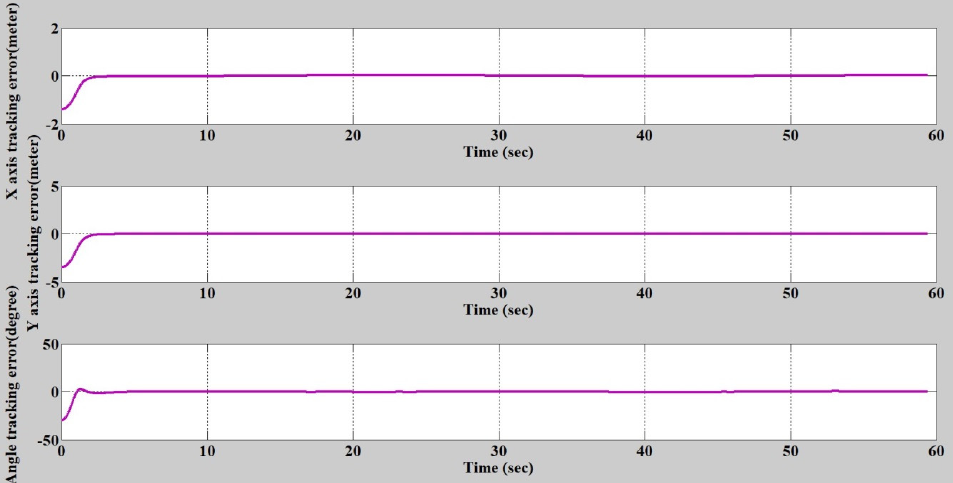
Figure 16. Results of S-type trajectory tracking torques concerning initial point ( x c = 1.9 m, y c = 0 m).